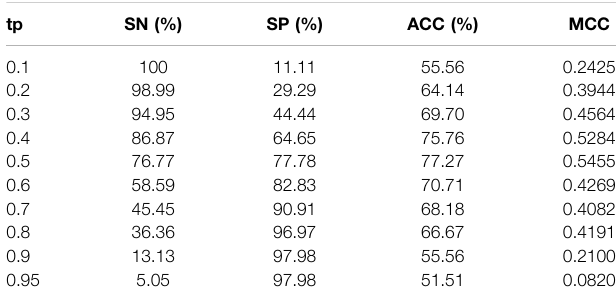
TABLE6| PerformanceofBBPpredictintheindependenttestingdatasetwhentp